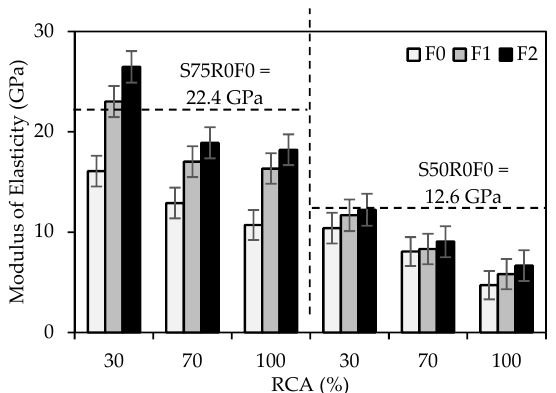
Figure 12. Modulus of elasticity of alkali-activated slag concrete mixtures with different RCA replacement percentages and SF volume fractions.